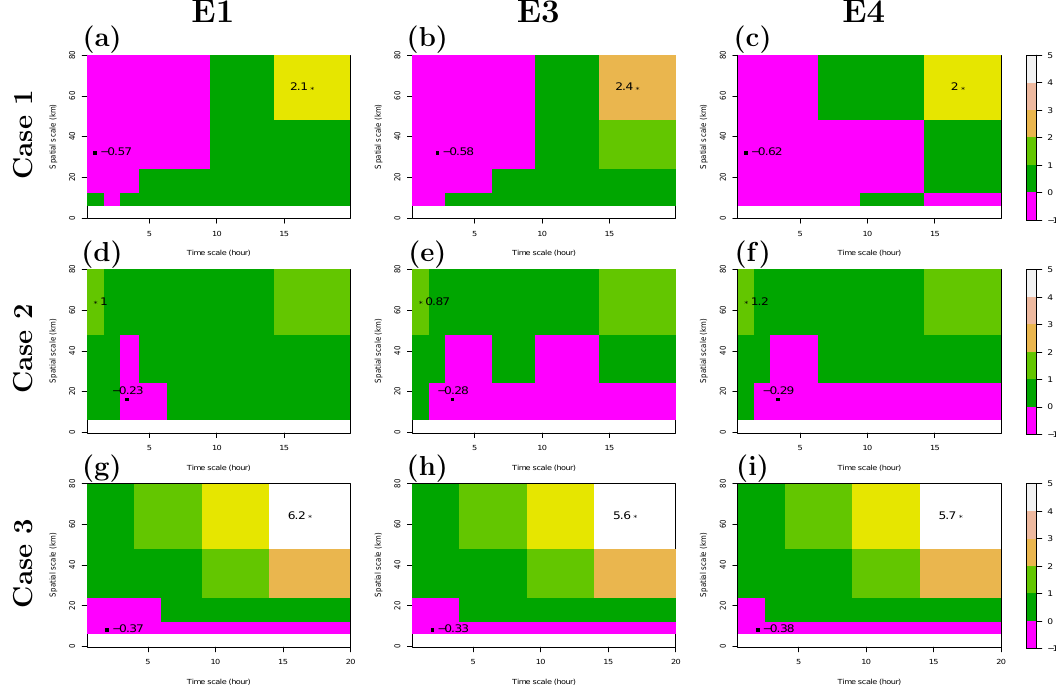
Fig. 12. Normalised anomalies of average forecast maximum intensity relative to the observed maximum intensity, for (a–c) Case 1, (d– f) Case 2 and (g–i) Case 3, and for the (a,d,g) E1, (b,e,h) E3 and (c,f,i) E4 ensembles. Extreme values are plotted on each diagram.